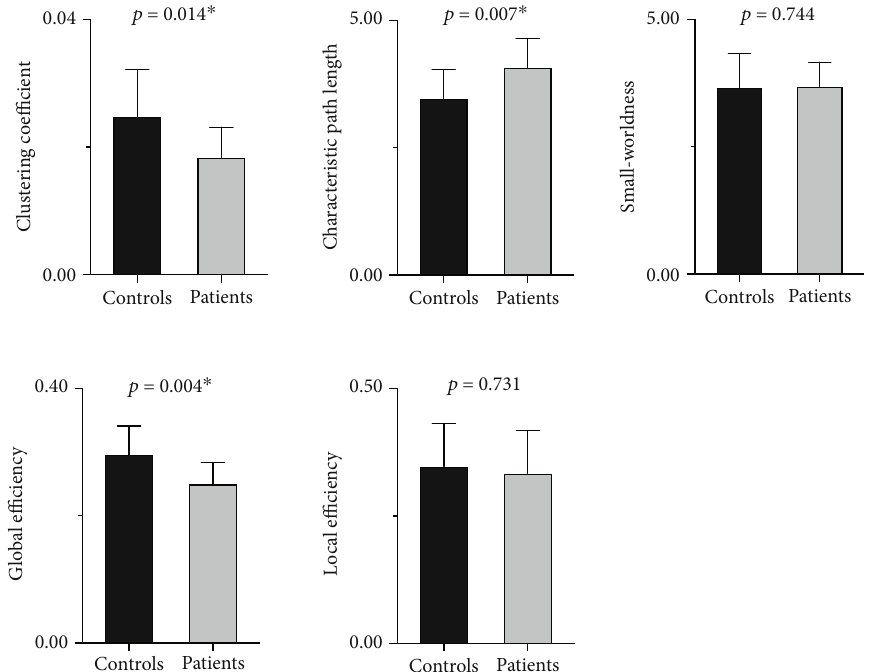
Figure 2: Comparison of the global topological properties of brain structural networks between patients and normal